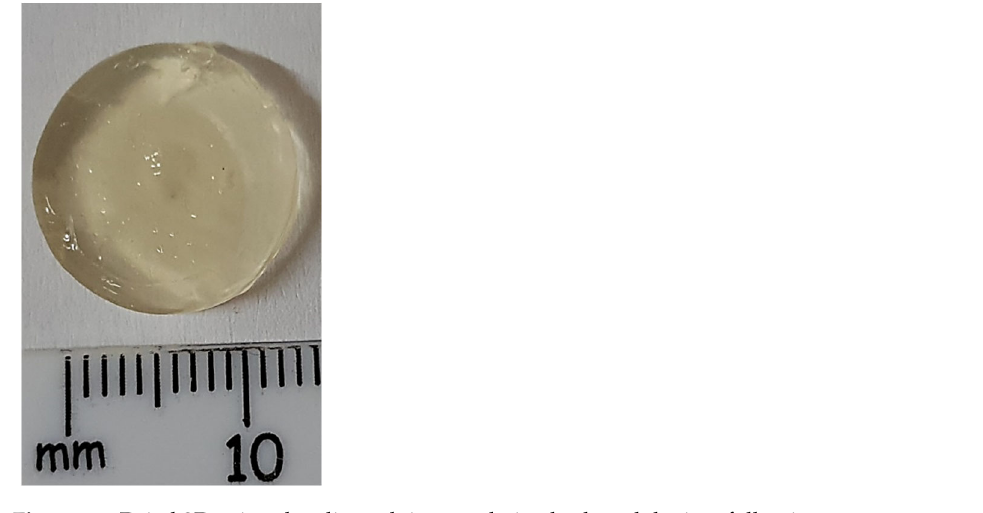
Figure 10. Dried 3D printed sodium alginate-gelatine hydrogel devices following temperature and chemical crosslinking in CaCl 2 .